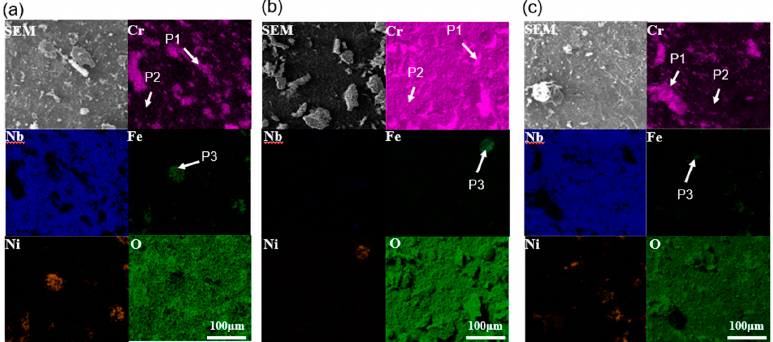
Figure 9. Elemental distribution maps of oxide surface after oxidation at 1000 °C for 100 h: ( a ) 0 ° sample; ( b ) 55 ° sample; ( c ) 90 ° sample. Table 2. Energy-dispersive X-ray spectroscopy (EDS) point analysis results (wt. %) at points 1–3 for alloy specimens shown in Figure 7 (after oxidation at 700 °C for 4h and 100 h) and Figure 9 (after oxidation at 1000 °C for 100 h).